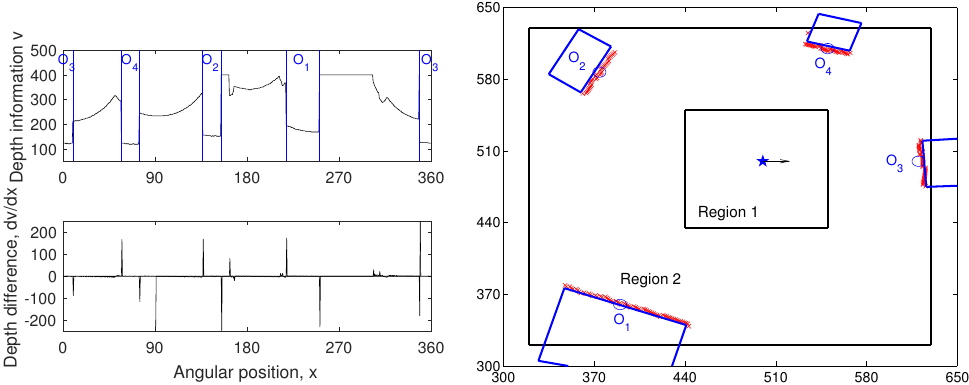
Figure 3. Example of depth snapshot ( left : depth snapshot for env1 and the derivative of the depth, right : close landmark objects (blue circles with labels) extracted from the depth snapshot). Black rectangles with label ‘Region 1’ and ‘Region 2’ (green dashed rectangle in Figure 2) include testing